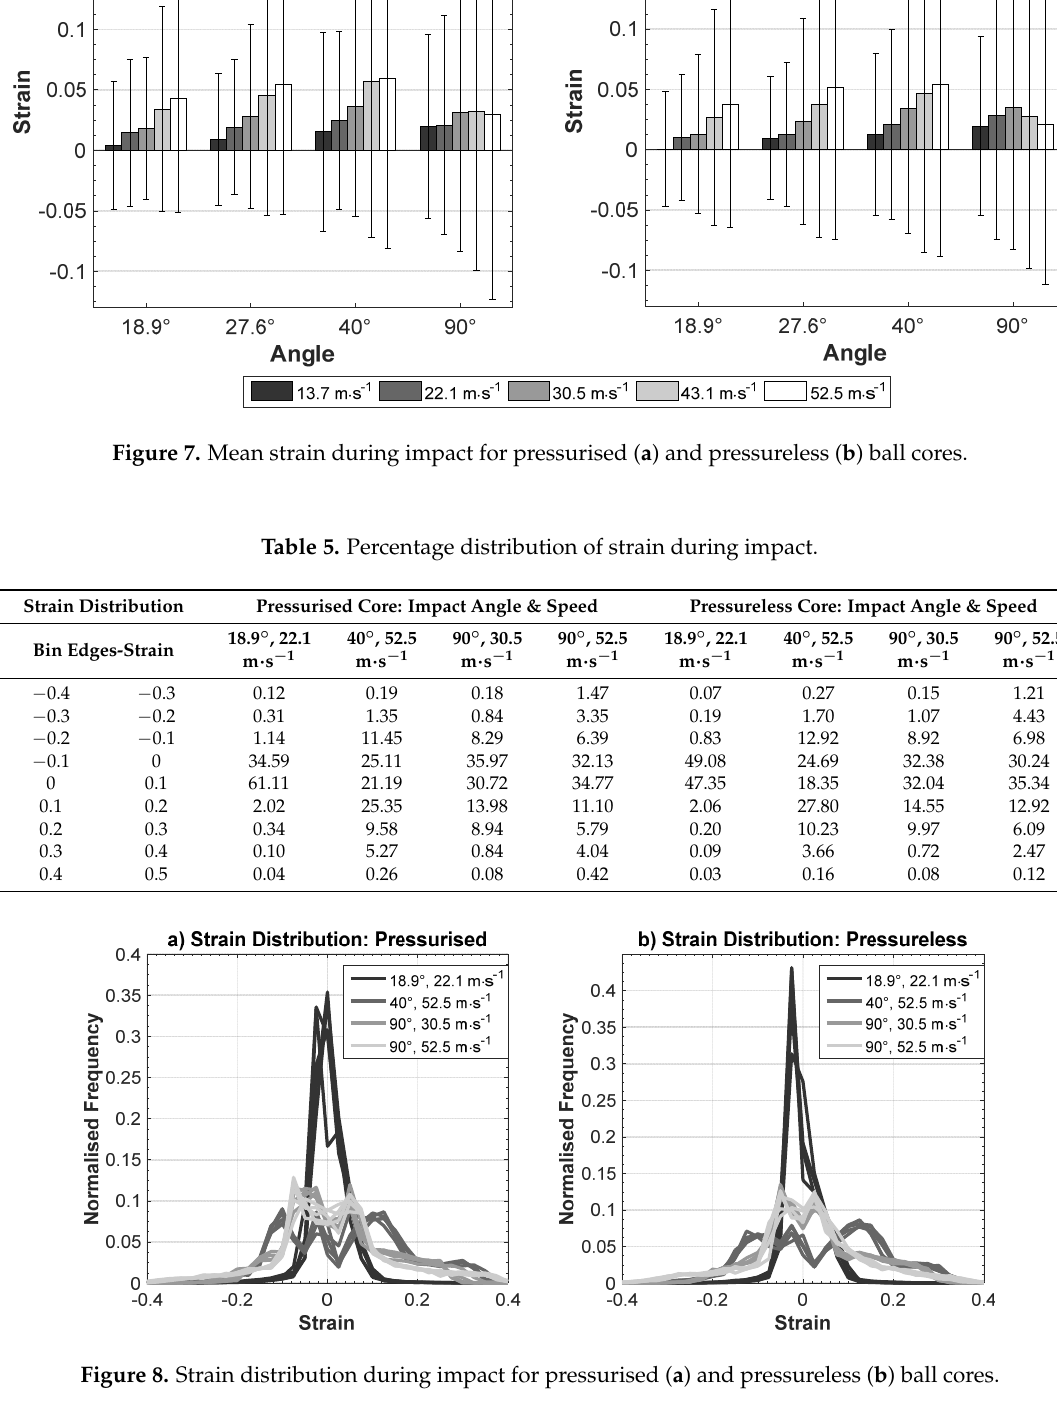
Figure 9. Mean strain rate during impact for pressurised ( a ) and pressureless ( b ) ball cores.